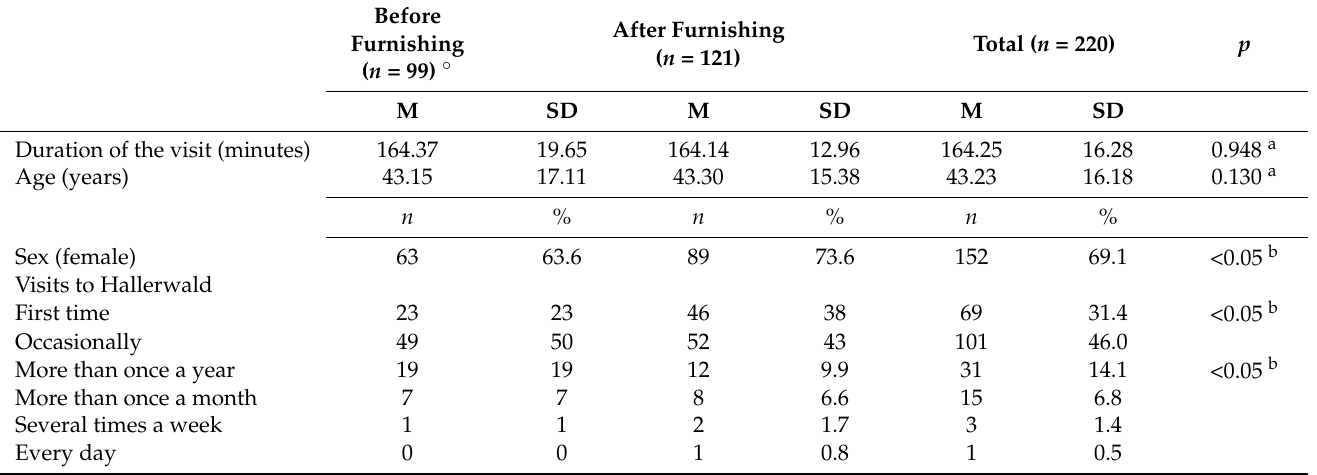
Table 1. Characteristics of the study